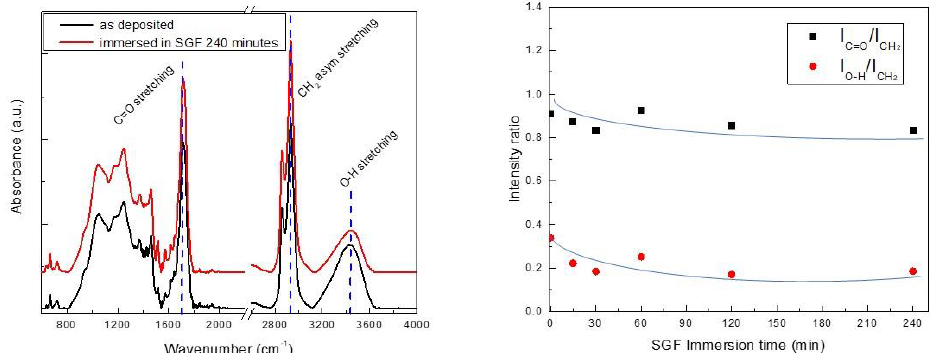
Figure 5. FTIR spectra of shellac film as-deposited and film immersed in simulated gastric fluid (SGF) for 240 min. Relative intensities of the absorption bands of O–H and C=O (3423 and 1711 cm − 1 , respectively) normalized to the CH 2 band (the strongest band of at 2927 cm − 1 ).